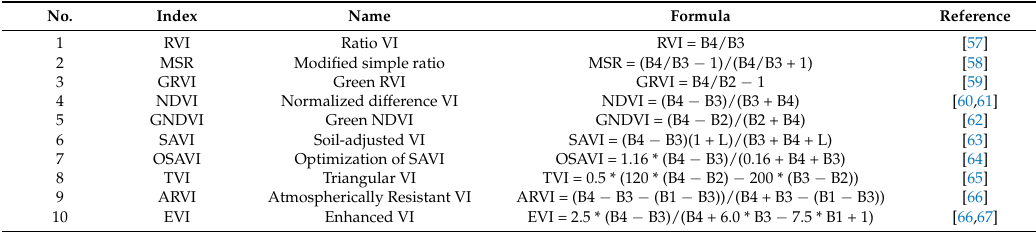
Figure 3. Flow chart of remotely sensed winter wheat leaf area index inversion. Table 3. A list of vegetation index studied in this study.